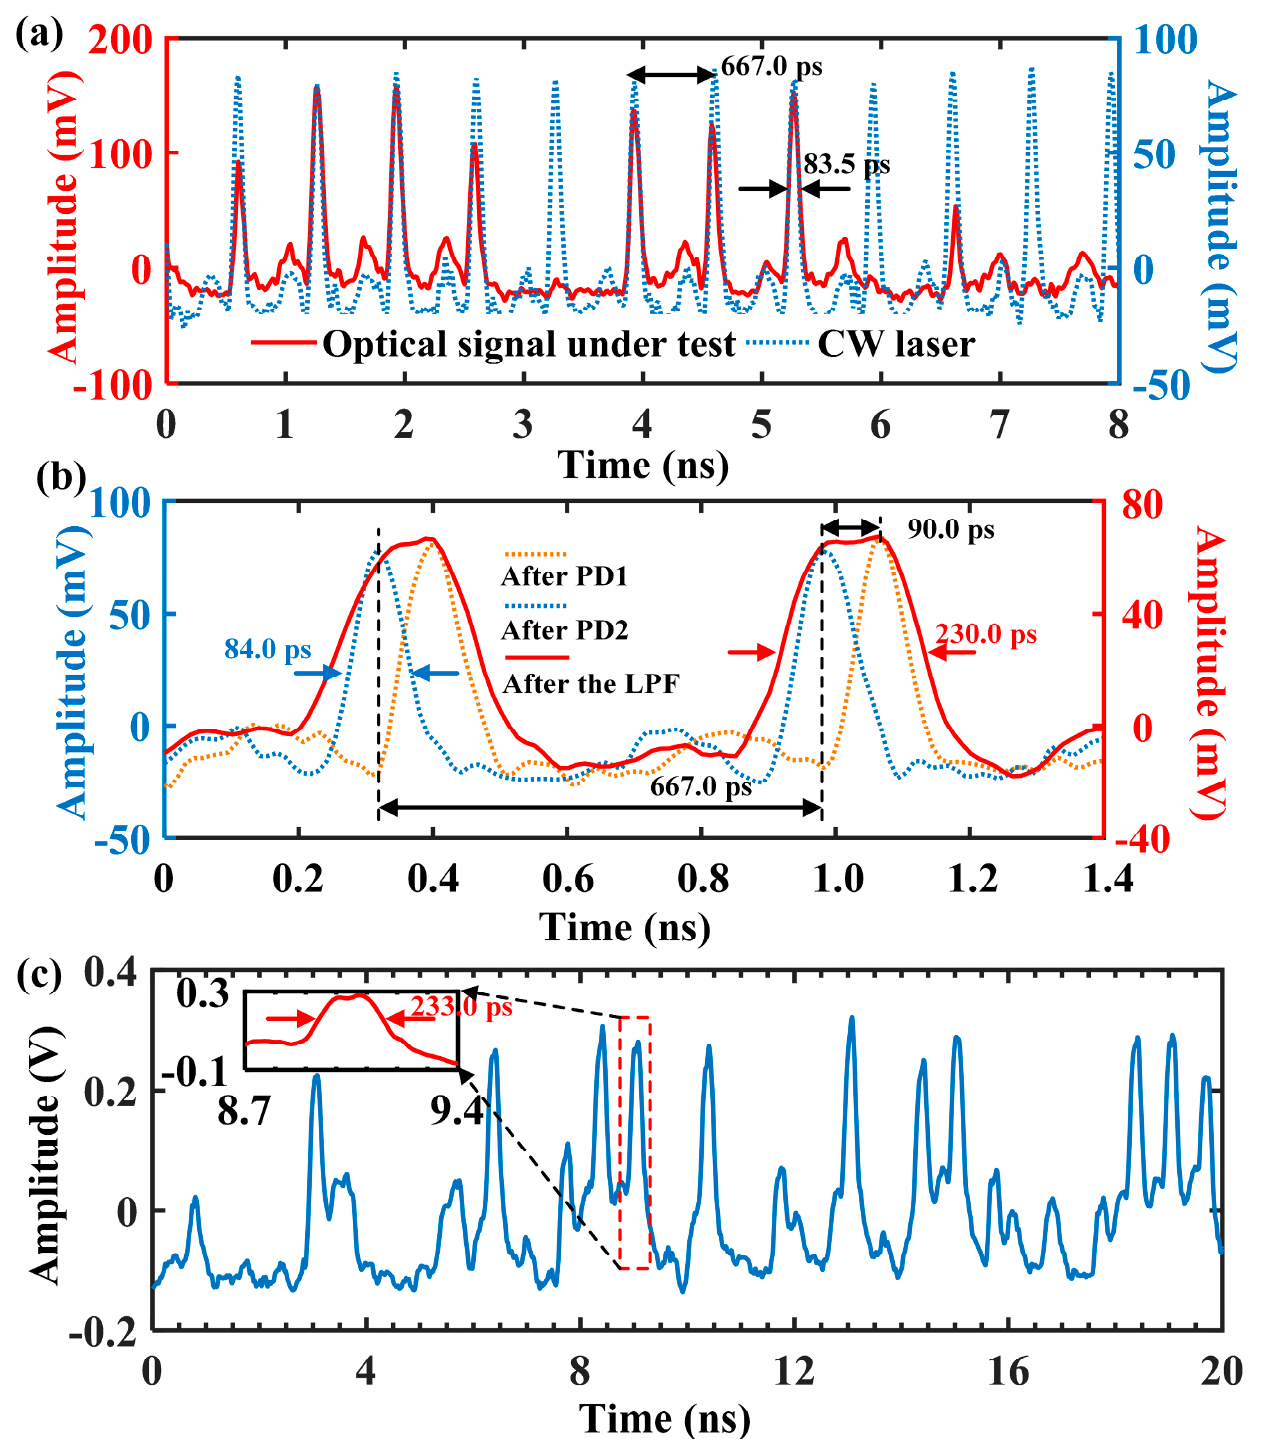
Figure 3. ( a ) The measured optical pulse train after the MZM, and the electrical sampled pulse train after the LPF when the input lightwave of the MZM is from ( b ) a continuous wave laser, or ( c ) a 2.5 G transmitter.